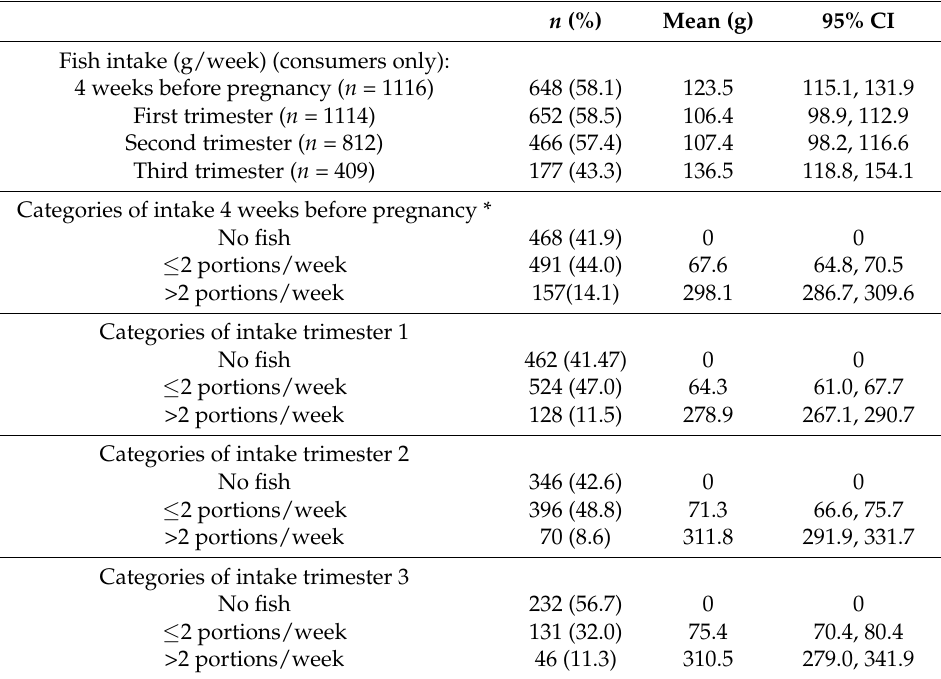
Table 1. Self-reported fatty fish intake across